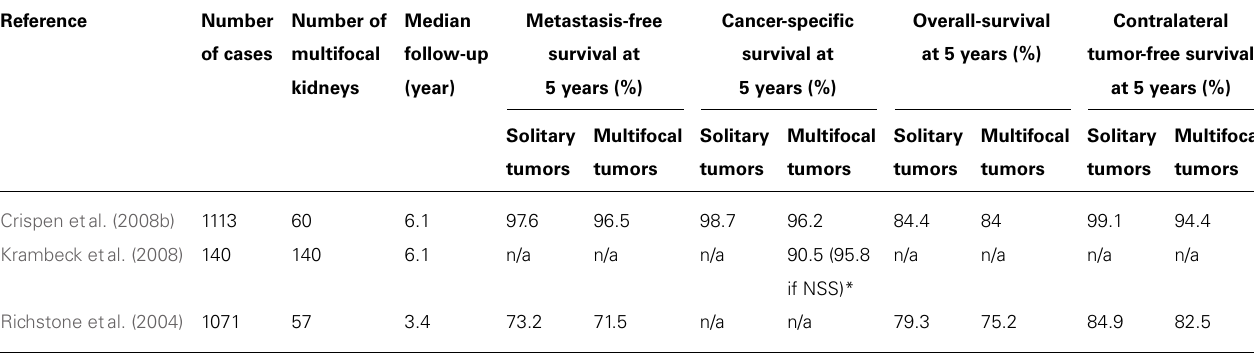
Table 2 | Oncologic outcomes for the study